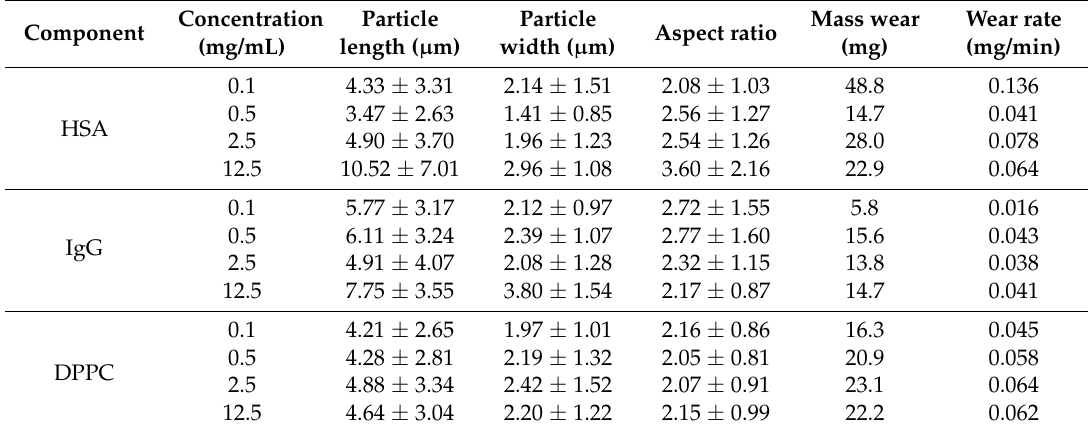
Table 1. Morphology and wear of PEEK particles in different components of synovial